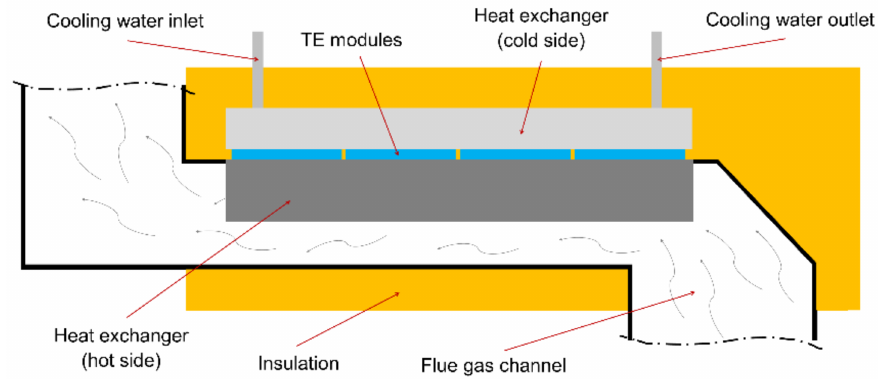
Figure 8. The simplified scheme of the prototype version of the developed TEG dedicated for installation in the flue gas channel (TEG No. 5).